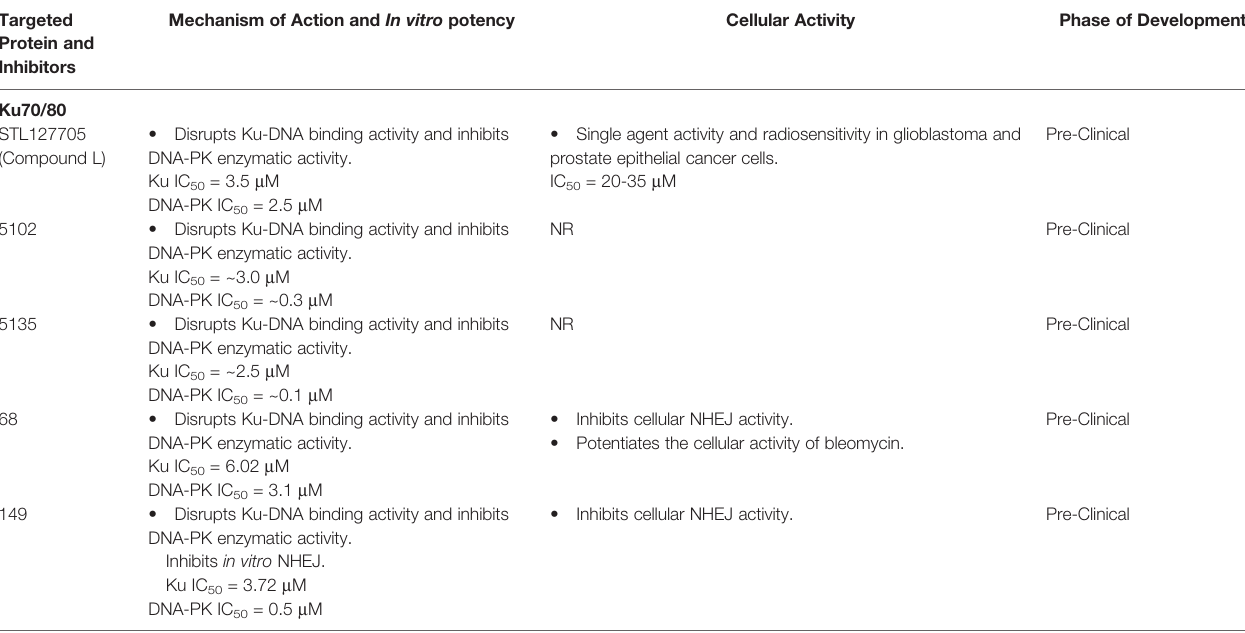
TABLE 1 | A summary of non-PIKKs DSB Repair inhibitors. Mechanism of Action and In vitro potency Cellular Activity Phase of